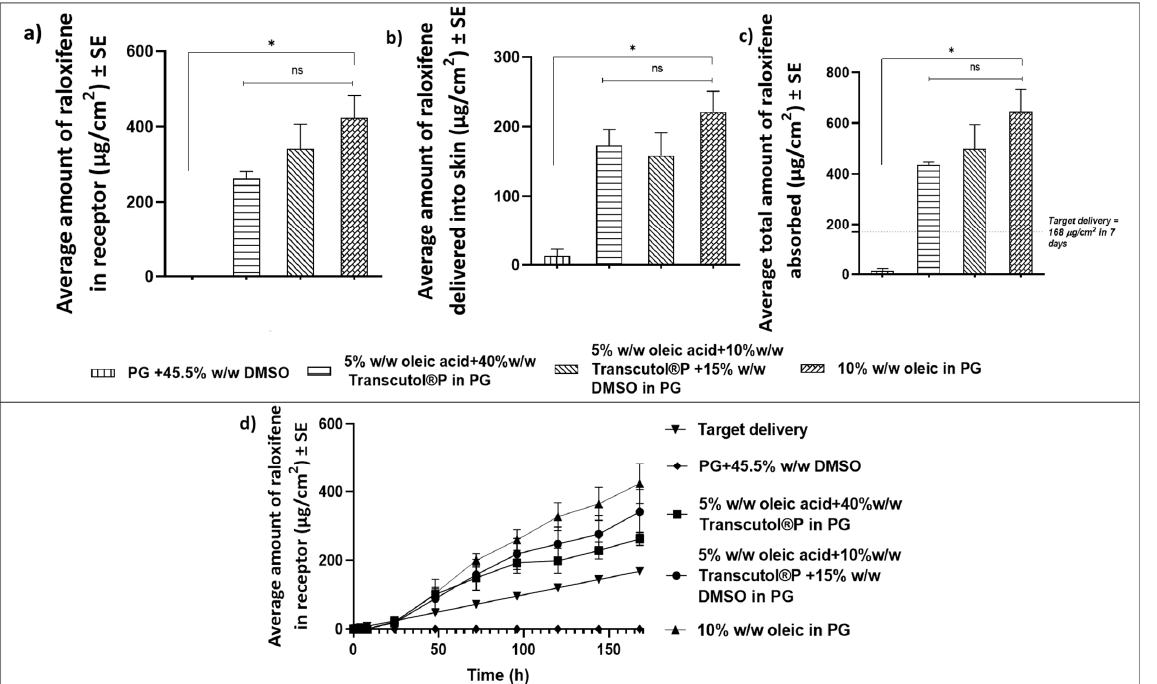
Figure 2. Screening of chemical enhancers for delivery of raloxifene: ( a ) cumulative amount of raloxifene delivered into the receptor after 7 days; ( b ) amount of raloxifene delivered into the skin at the end of 7 days; ( c ) total amount of raloxifene delivered into and across the skin in 7 days; ( d ) permeation profile of raloxifene. Statistical analysis was performed with a Kruskal–Wallis test. ns indicates no significant difference between groups ( p > 0.05); * indicates a significant difference between groups ( n = 4, p < 0.05).